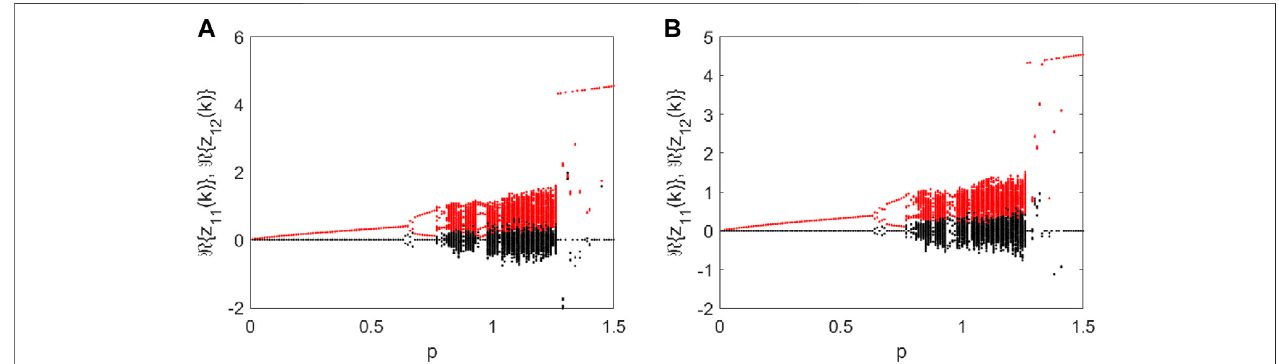
FIGURE11| BifurcationdiagramofthemultidimensionalIkedamapin Eq.17 withrespectto p : (A) N =2; (B) N =3.Otherparameters: B =0.76, ρ =0.4,and a =6.